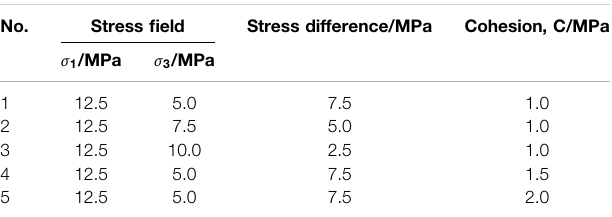
TABLE 1 | Numerical simulation program for case 1. No. Stress fi